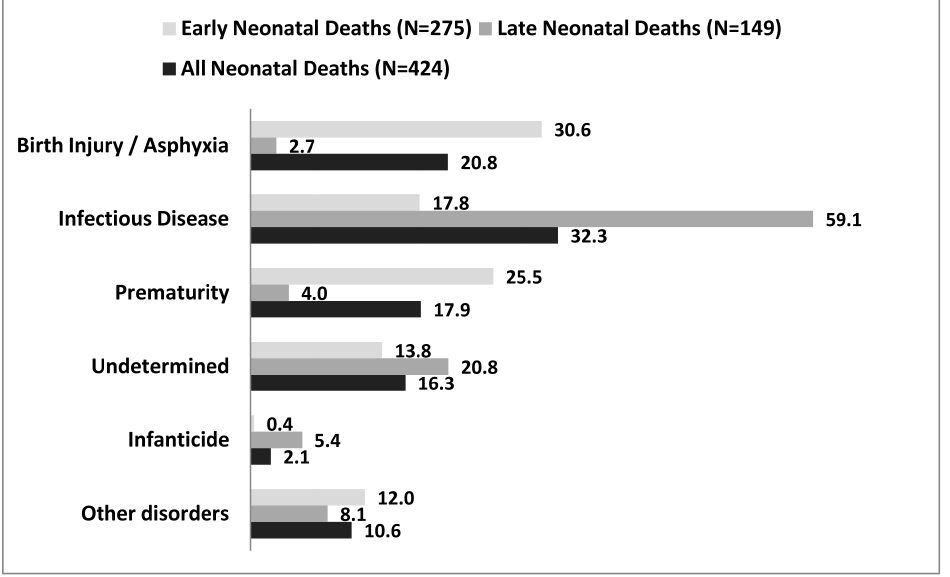
Figure 2. Causes of Early and Late Neonatal Deaths in Navrongo HDSS from 2003 to 2009*. *shown as a percent of early, late, all neonatal deaths.